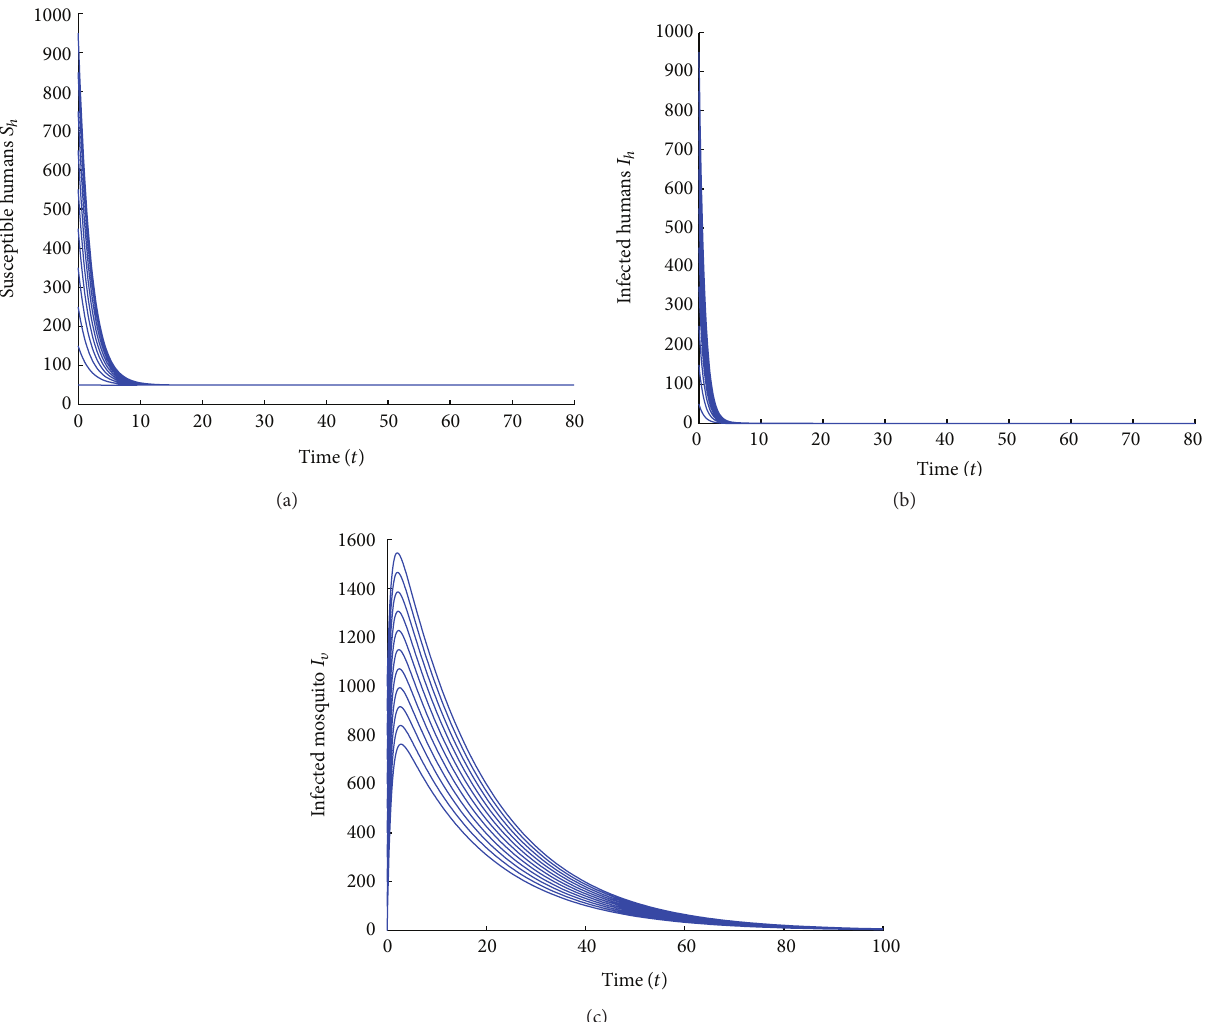
Figure 5: Simulations of the model (5) showing (a) the number of susceptible humans, (b) the number of infected humans, (c) the number of infected mosquitoes, as a function of time using the parameters: 𝑏 = 0.5 , Λ ℎ = 25 , Λ 𝑉 = 500 , 𝛽 1 = 0.00001 , 𝛽 2 = 0.005 , 𝜇 ℎ = 0.5 𝜇 𝑣 = 0.06 , = 0.0001 , and 𝛾 = 0.6 (so that ℜ = 0.0789 < 1 𝜎 = 0.8 , 𝛿 ℎ ℎ 0